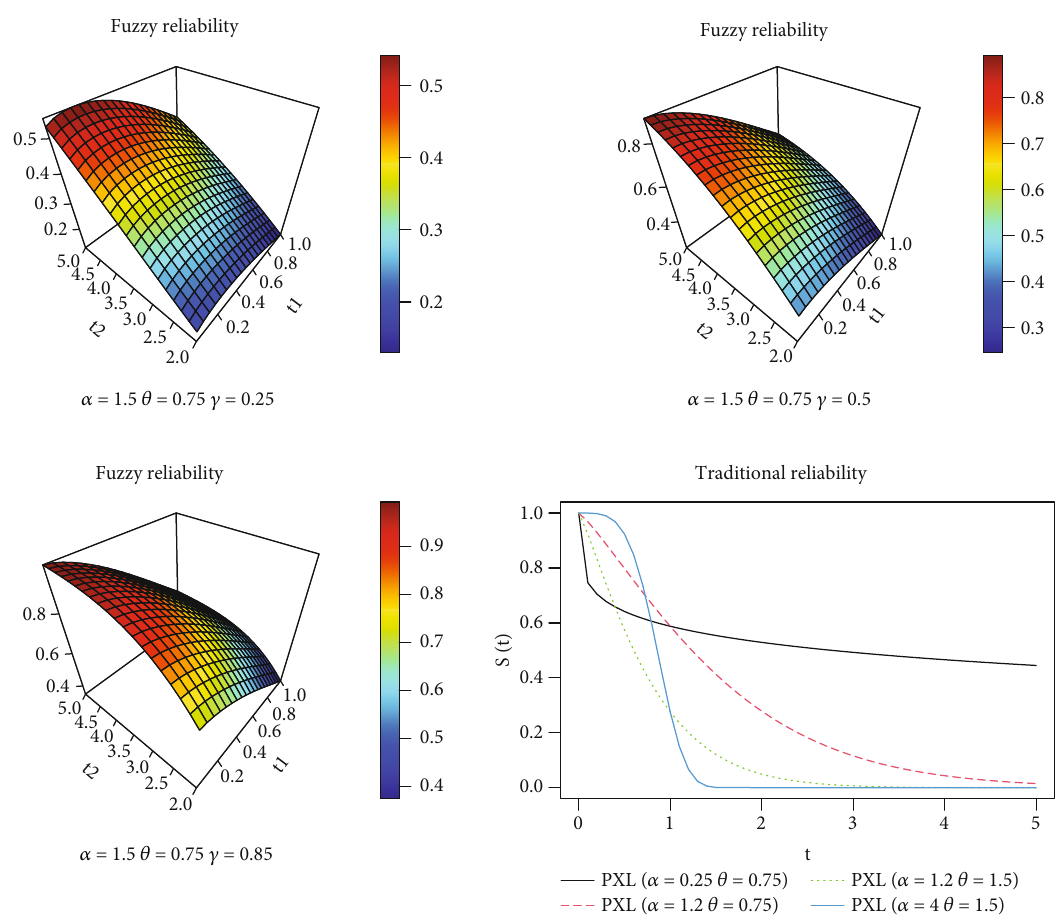
Figure 3: Plots of traditional and fuzzy reliability.